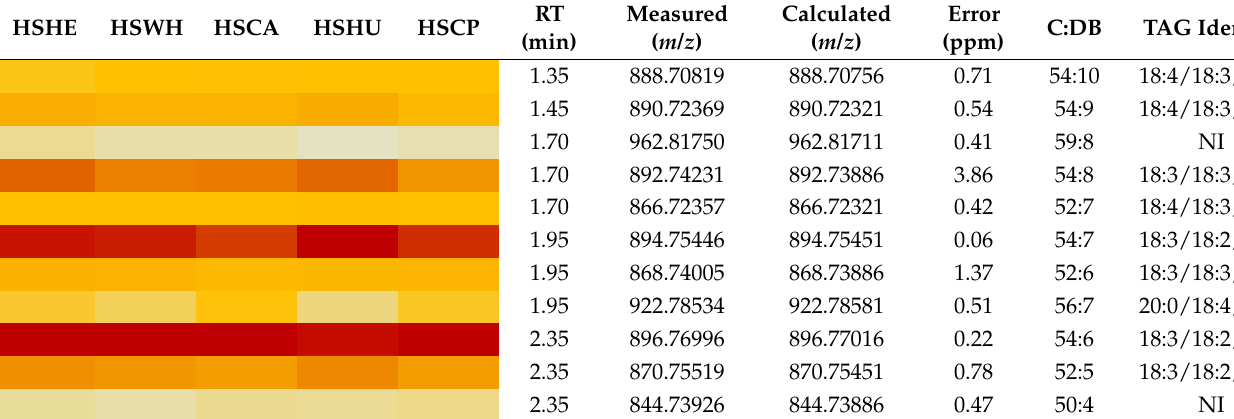
Table 2. Heat map of triacylglycerols (TAGs) identified in oil extracted from hemp hearts (HSHE), hemp whole seeds (HSWH), hemp cake (HSCA), hemp seed hulls (HSHU) and cold-pressed hemp oil (HSCP).